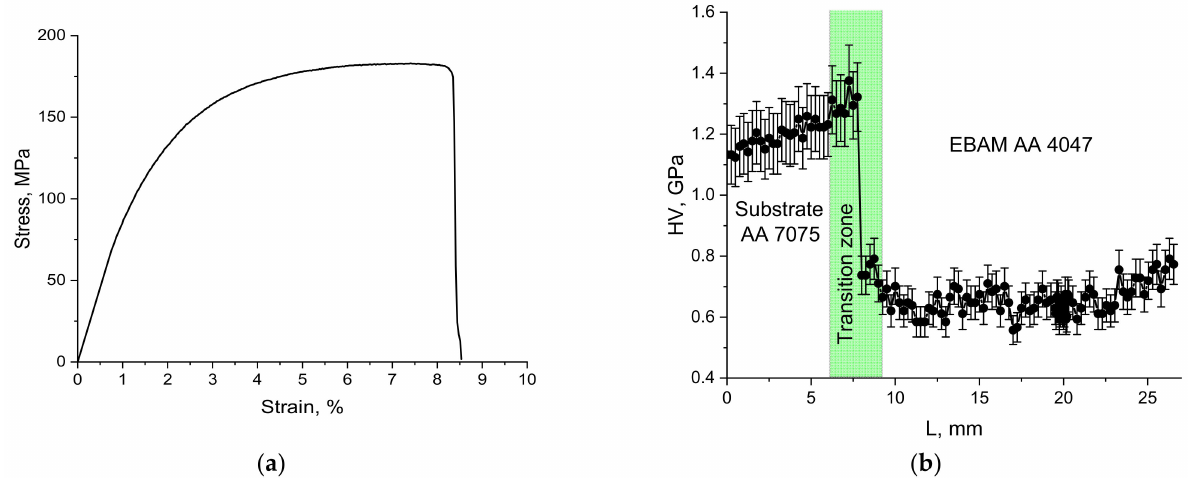
Figure 13. Stress–strain curve for tensile test ( a ) and microhardness profile ( b ).